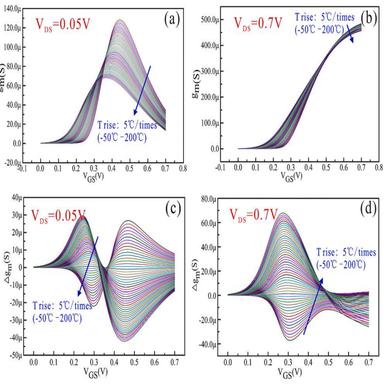
(a) and (b) gm of FinFET devices at VDS = 0.05 V and VDS = 0.7 V with different temperature; (c) and (d) The changes in gm at VDS = 0.05 V and VDS = 0.7 V with different T.